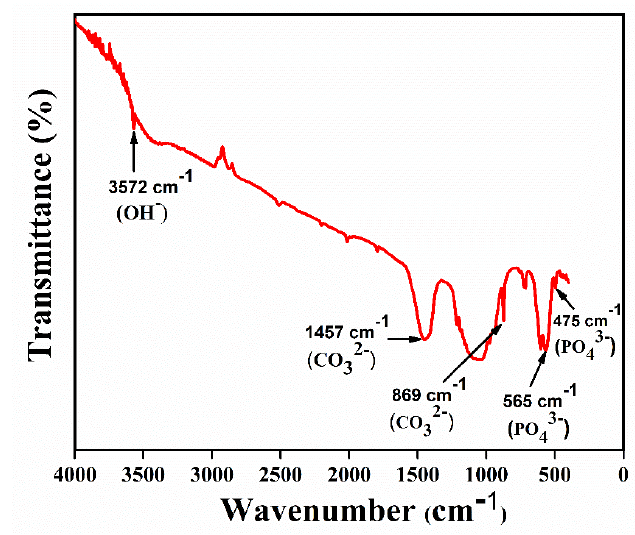
Figure 2. FTIR spectra of HAp powders.